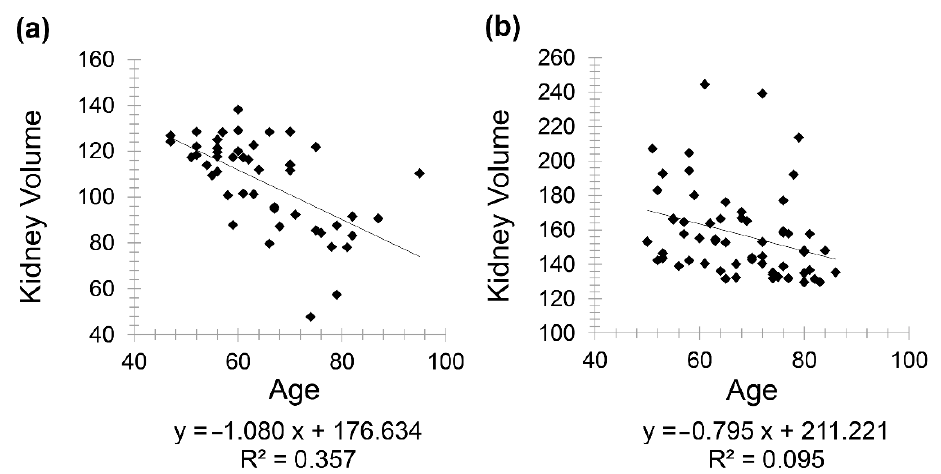
Figure 1. Scatter plot graphs showing negative correlation between kidney volume and age ( r = − 0.597) in males ( a ) and ( r = − 0.676) in females ( b ) in healthy patients.